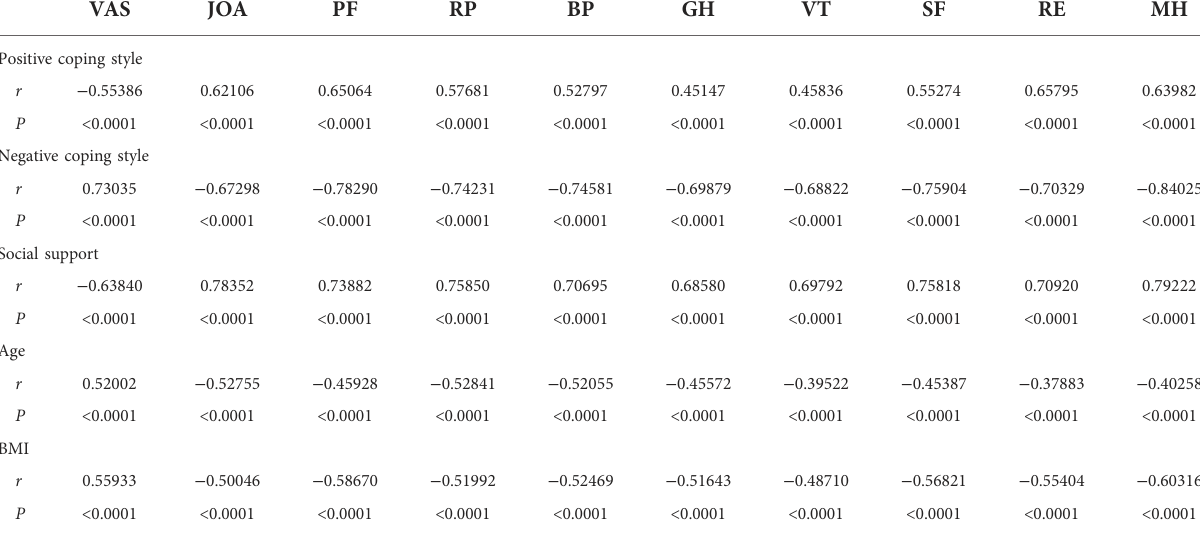
TABLE 3 Correlation between quality of life and various factors after lumber